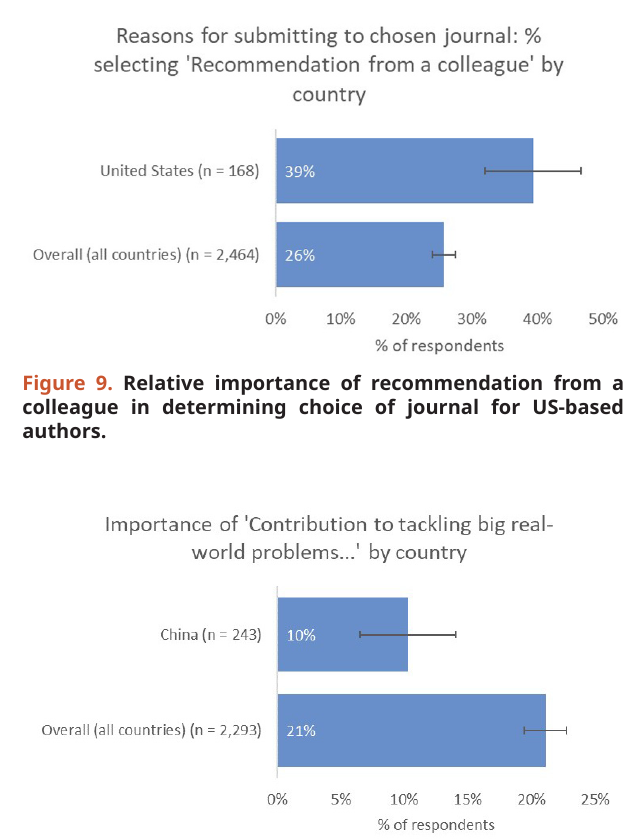
Figure 10. Relative importance of tackling real-world problems to China-based authors.